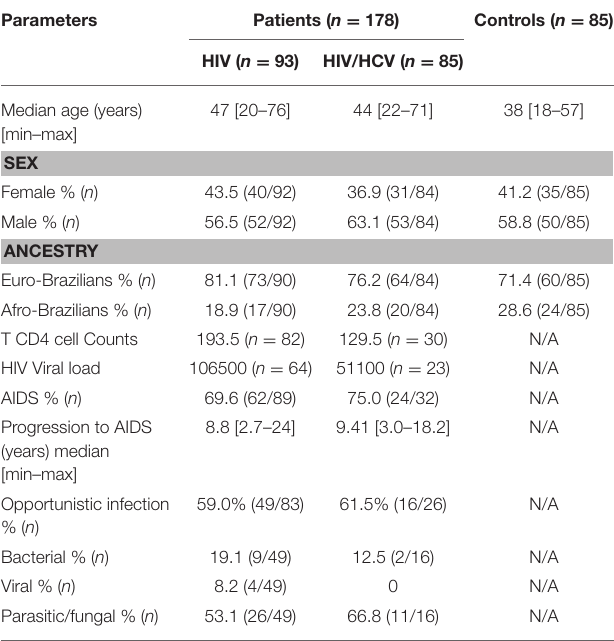
TABLE 1 | Clinical and demographic characteristics of controls, HIV and HIV/HCV patients.